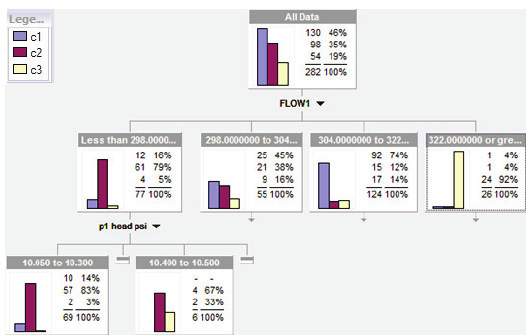
Fig. 6. Decision tree 2 for Stage 2